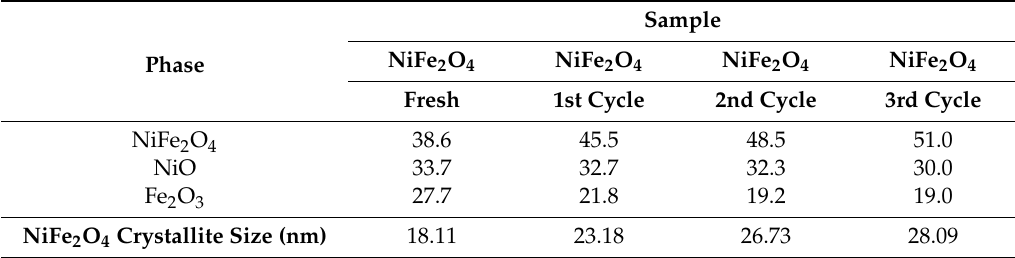
* Using X’Pert HighScore TM